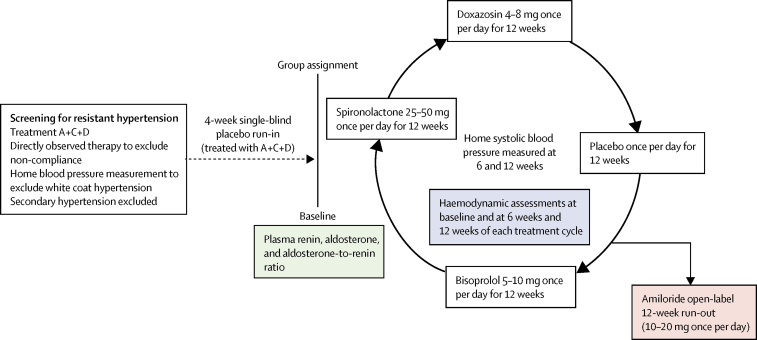
PATHWAY 2 study designStages in the crossover trial at which measurements for the three mechanistic substudies were taken. Green shows substudy 1, blue shows substudy 2, and pink shows substudy 3. During the 12-week drug cycles, the lower dose was given for the first 6 weeks, then the higher dose was given for the second 6 weeks. No washout period was used between cycles. The figure shows one of the 24 possible passages through the drug cycles, the order of which was randomly assigned within blocks of 24 patients. A+C+D=an angiotensin-converting enzyme inhibitor or angiotensin receptor blocker, a calcium channel blocker, and a diuretic.